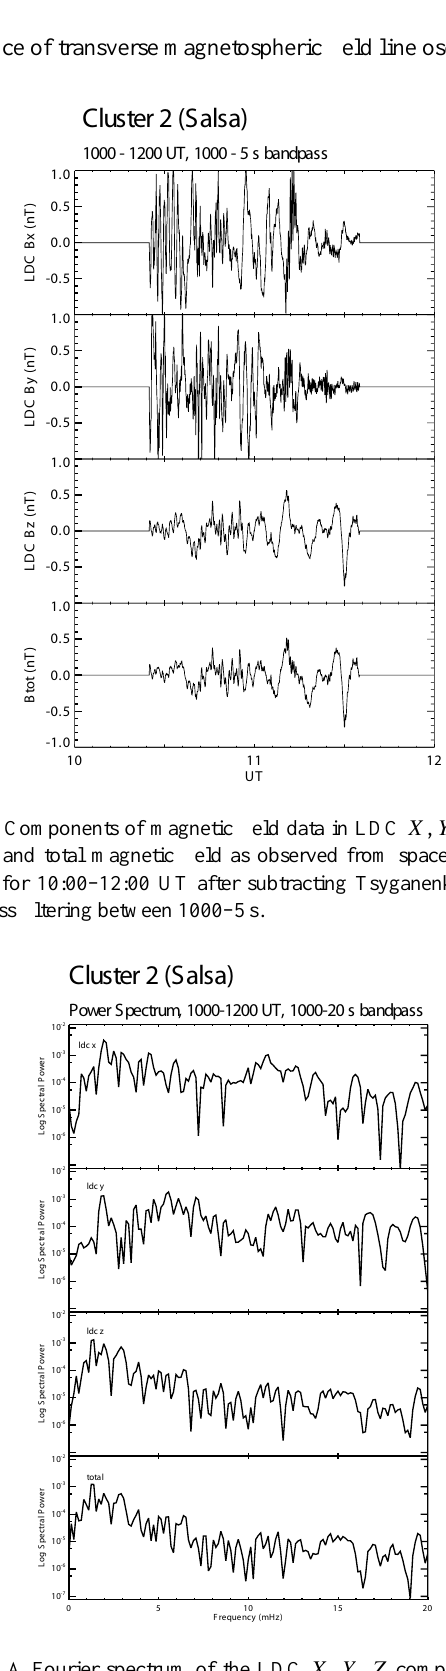
Fig. 7. A Fourier spectrum of the LDC X , Y , Z component and total magnetic field from Cluster 2, from 10:00–12:00 UT, bandpass filtered between